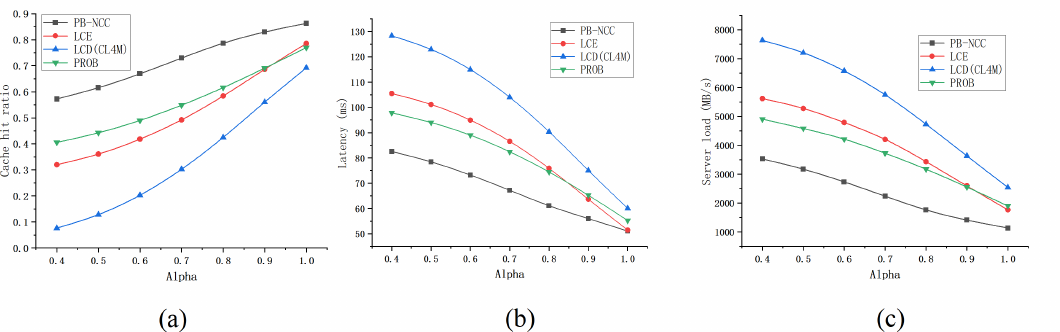
Figure 7. Comparison in the tree topology when the Zipf parameter α changes. ( a ) the cache hit ratio under different Zipf parameter α ; ( b ) the average latency under different Zipf parameter α ; ( c ) the server load under different Zipf parameter α .